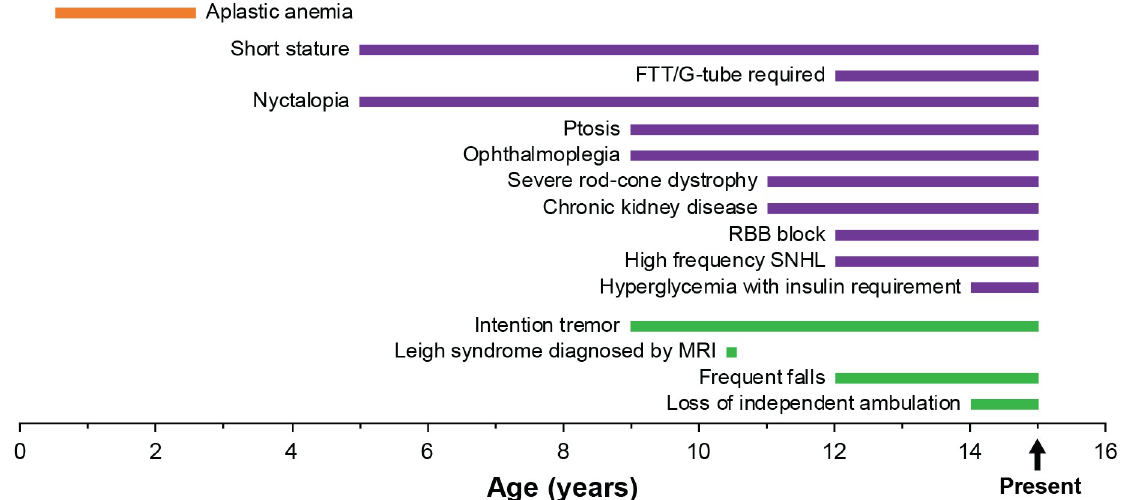
Fig 2. Timeline of proband’s mitochondrial disease clinical progression. Clinical manifestations associated with Pearson (orange), Kearns-Sayre (purple), and Leigh (green) syndromes are grouped. Manifestations through 14 years are indicated as ongoing to present.